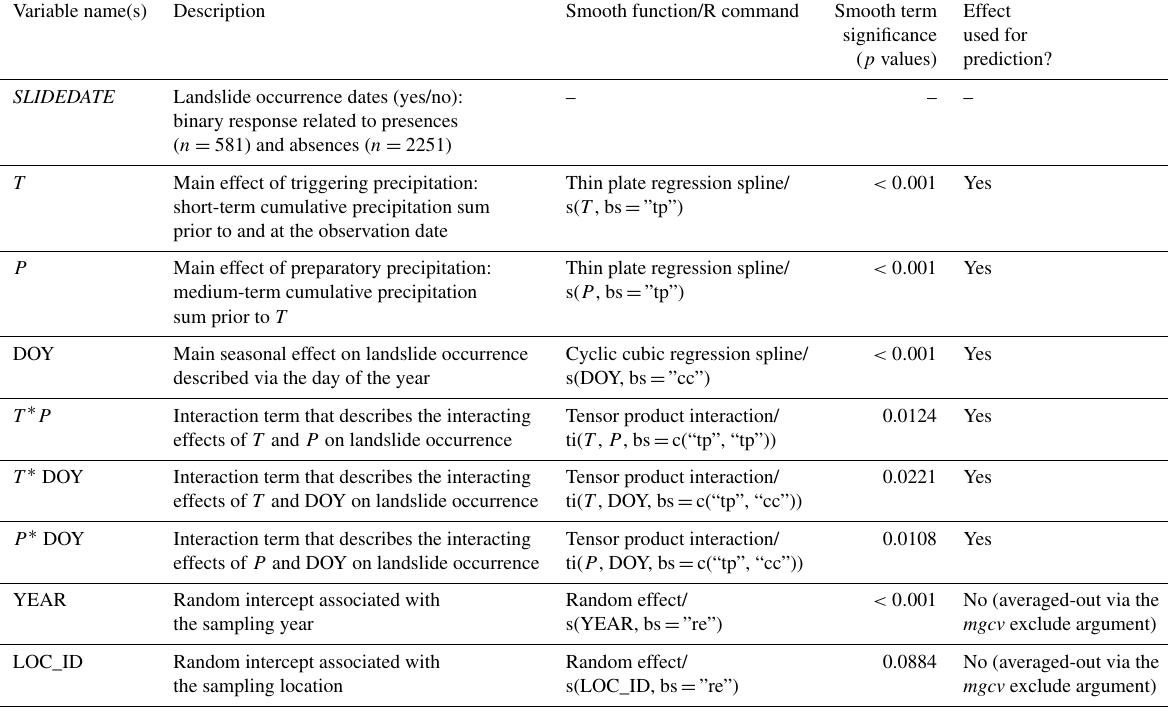
Table 1. Model setup and variables introduced into the binomial GAMM through the R software (package mgcv